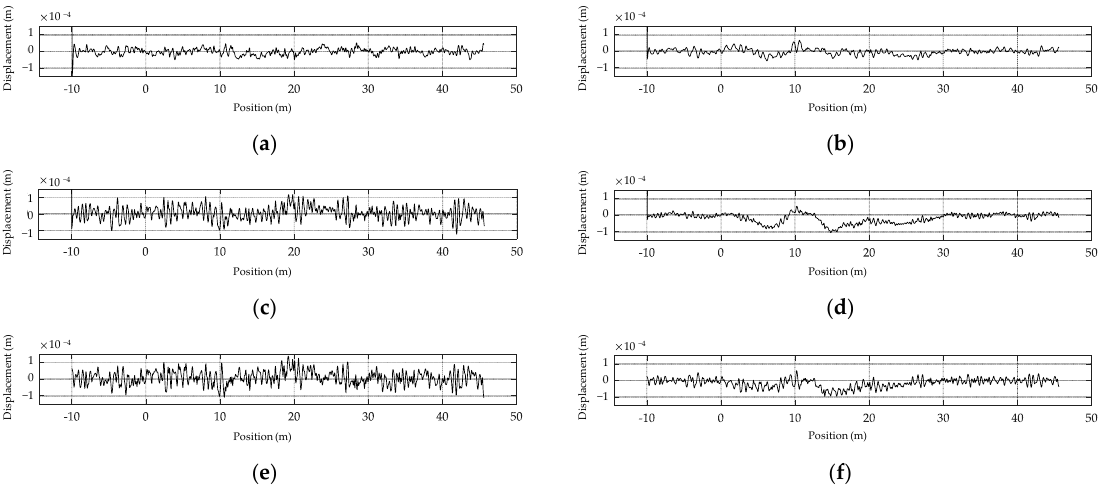
Figure A4. The residual of the correct/estimated road unevenness shown in Figures 10 and 12: ( a ) 𝑅(cid:3552) 𝑅(cid:3552) 𝑅(cid:3552) 𝑅(cid:3552) 𝑅(cid:3552) 𝑅(cid:3552) (cid:2869) − (cid:2870) in Scenario 1; ( b ) (cid:2869) − (cid:2870) in Scenario 6; ( c ) (cid:2869) − 𝑅 in Scenario 1; ( d ) (cid:2869) − 𝑅 in Scenario 6; ( e ) 𝑅(cid:3552) (cid:2870) − 𝑅 in Scenario 1; and ( f ) 𝑅(cid:3552) (cid:2870) − 𝑅 in Scenario 6. The histograms included in Figures 13–16 are enlarged in Figures A5–A14 for the convenience of the readers. .